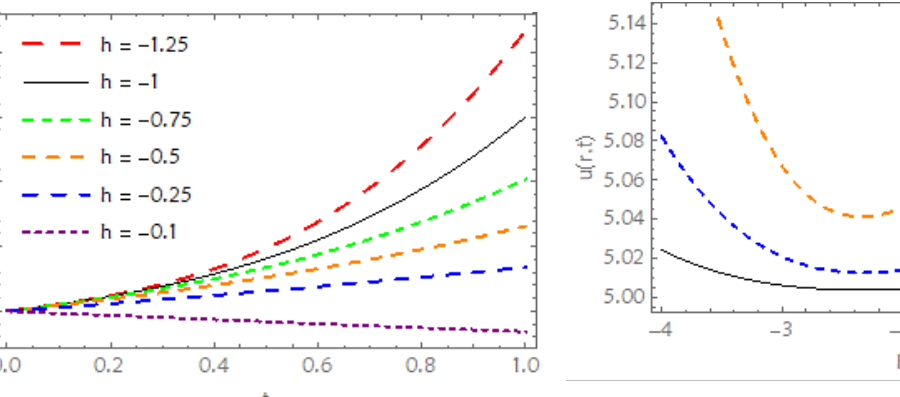
Fig. 5: (cid:126) -curve of q-HATM solution u ( r , t ) Vs. h when t = 0.01, r = 1, n = 2 for Ex.